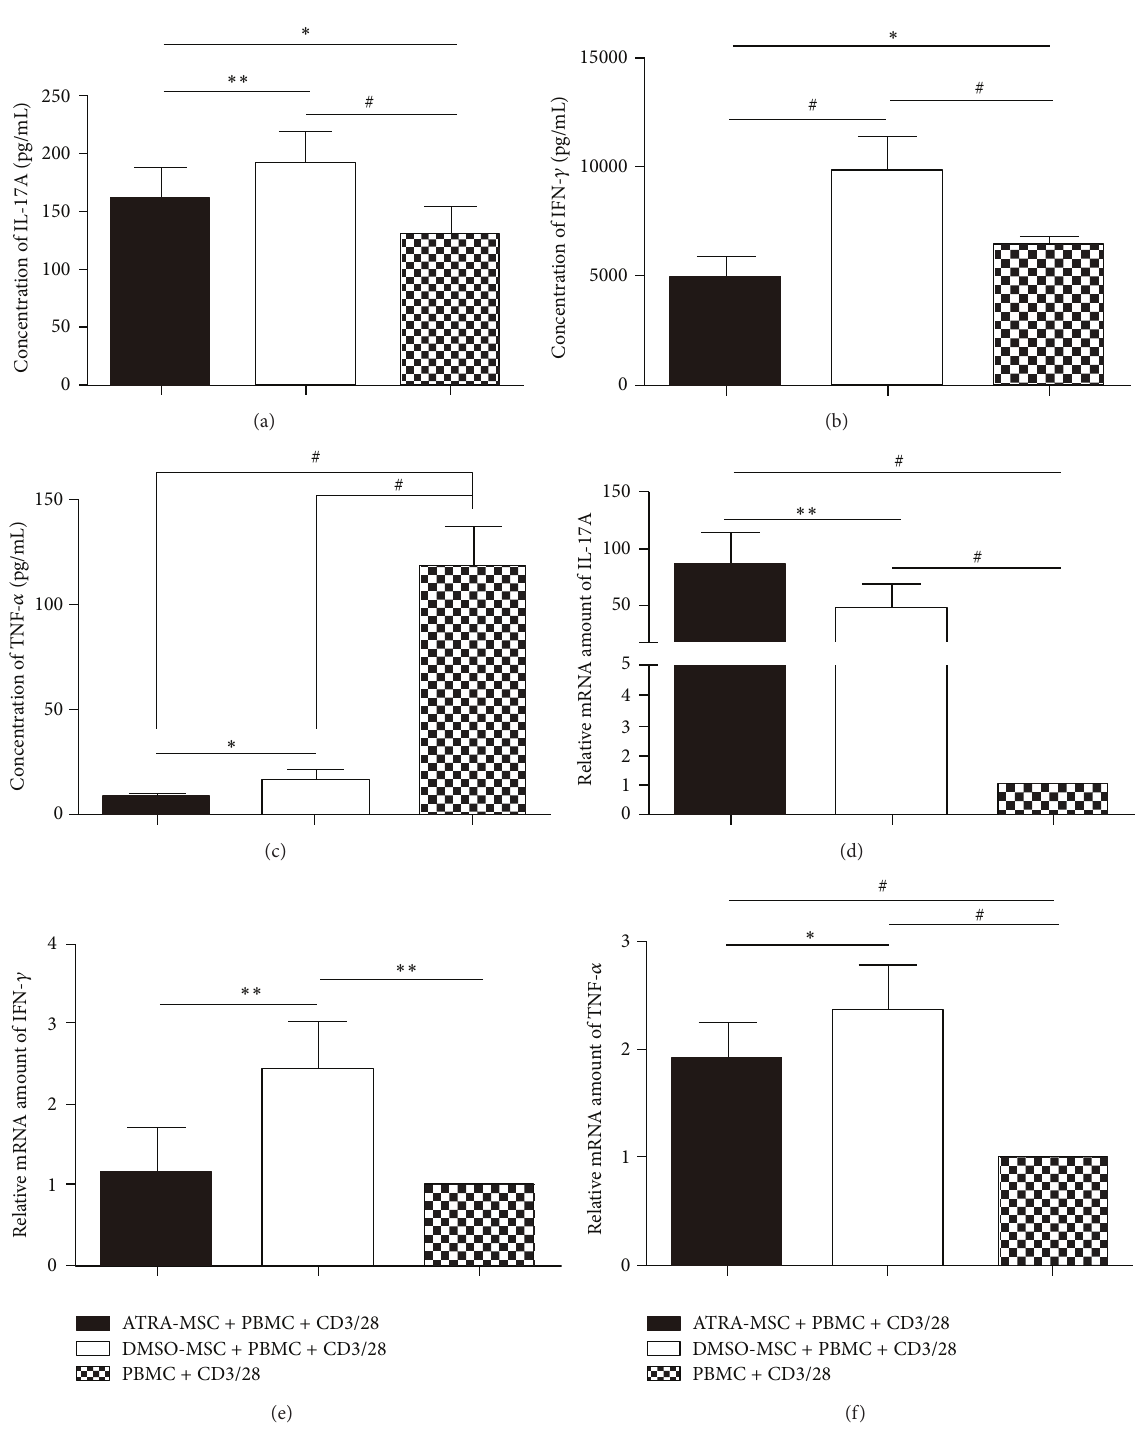
Figure 5: Secretion and gene transcription of IL-17A, IFN- 𝛾 , and TNF- 𝛼 in the coculture of MSCs and PBMCs. (a) Results of IL-17A secretion from CBA. (b) Results of IFN- 𝛾 secretion from CBA. (c) Results of TNF- 𝛼 secretion from CBA. (d) Results of IL-17A gene transcription from qPCR. (e) Results of IFN- 𝛾 gene transcription from qPCR. (f) Results of TNF- 𝛼 gene transcription from qPCR. One-way ANOVA was used. ∗ 𝑃 < 0.05 , ∗∗ 𝑃 < 0.01 , and # 𝑃 < 0.001